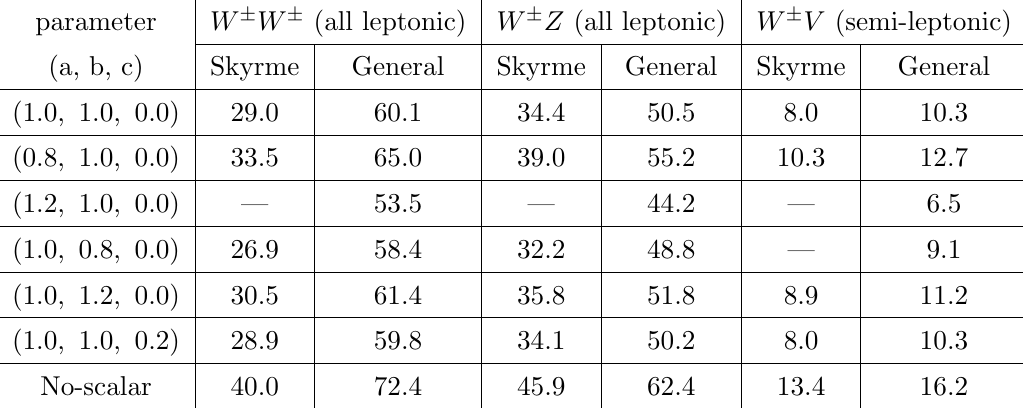
Table 1 . Upper bound on the mass of the EW-Skyrmion in the unit of TeV. Bounds for the case of the Lagrangian without scalar (cid:12)eld are also shown for